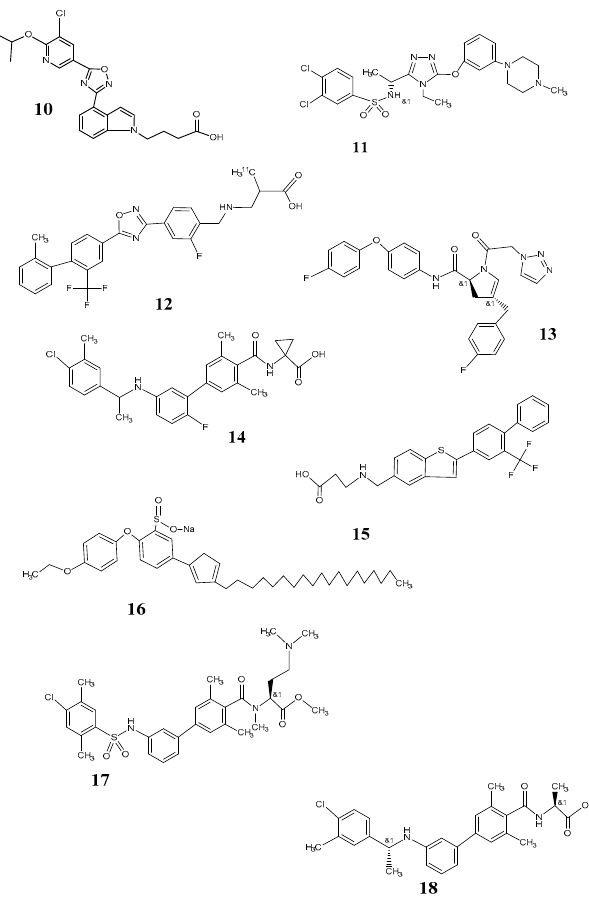
Figure 3. S1P receptor ligands 10 : GSK2018682; 11 TSAP0277308; 12 TZ3321; 13 XLS541; 14 Ex26; 15 AUY954; 16 CL2; 17 Prodrug 14; 18 NIBR0213.